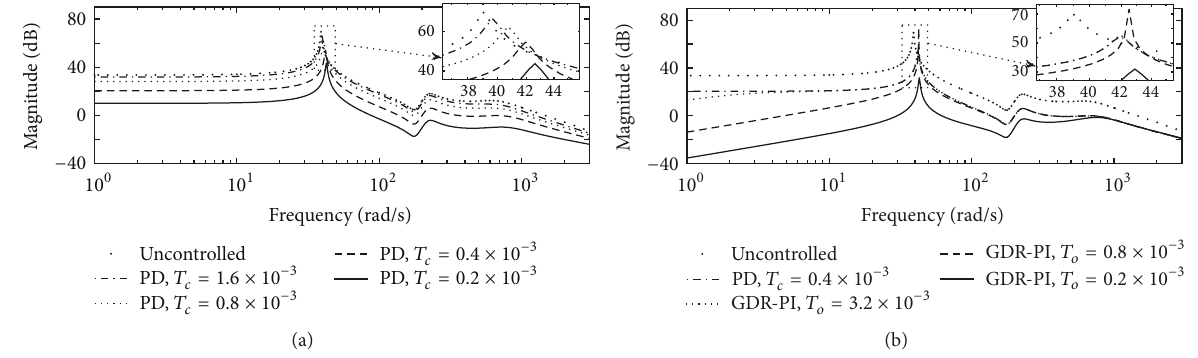
Figure 4: The frequency responses of the controlled and uncontrolled smart beam: (a) PD control configured with different 𝑇 𝑐 and (b) PD control and GDR control with PI observers configured with 𝑇 𝑐 = 0.4 × 10 −3 and different 𝑇 𝑜